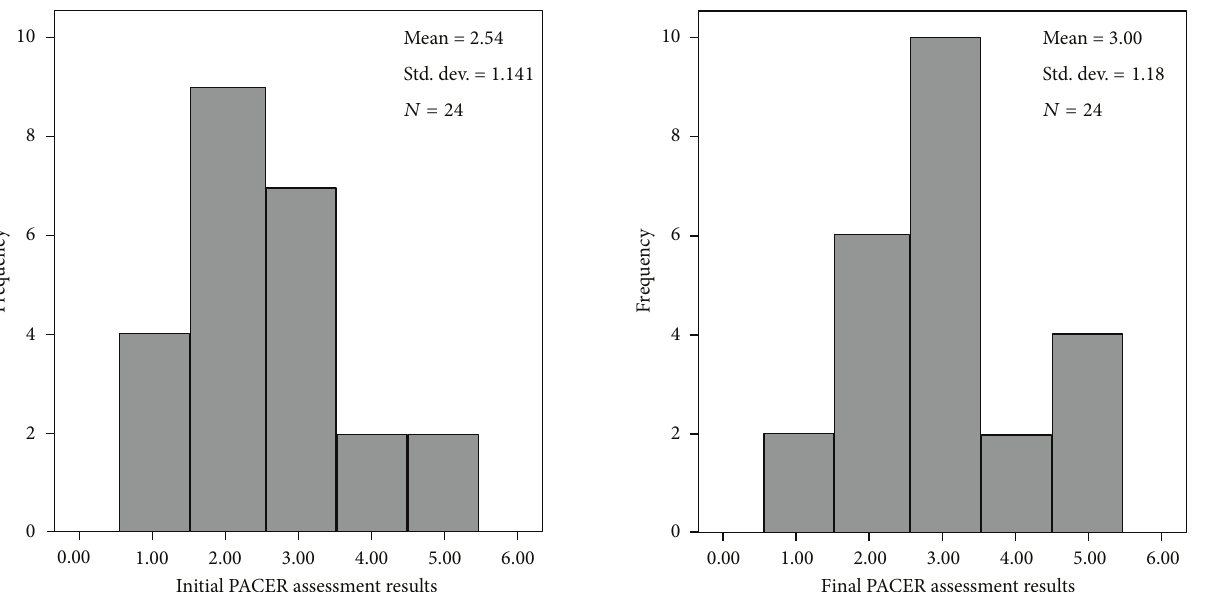
the difference in individual step count and the difference between PACER pre- and posttest ( 𝑟 = 0.318 , 𝑃 = 0.130 ).